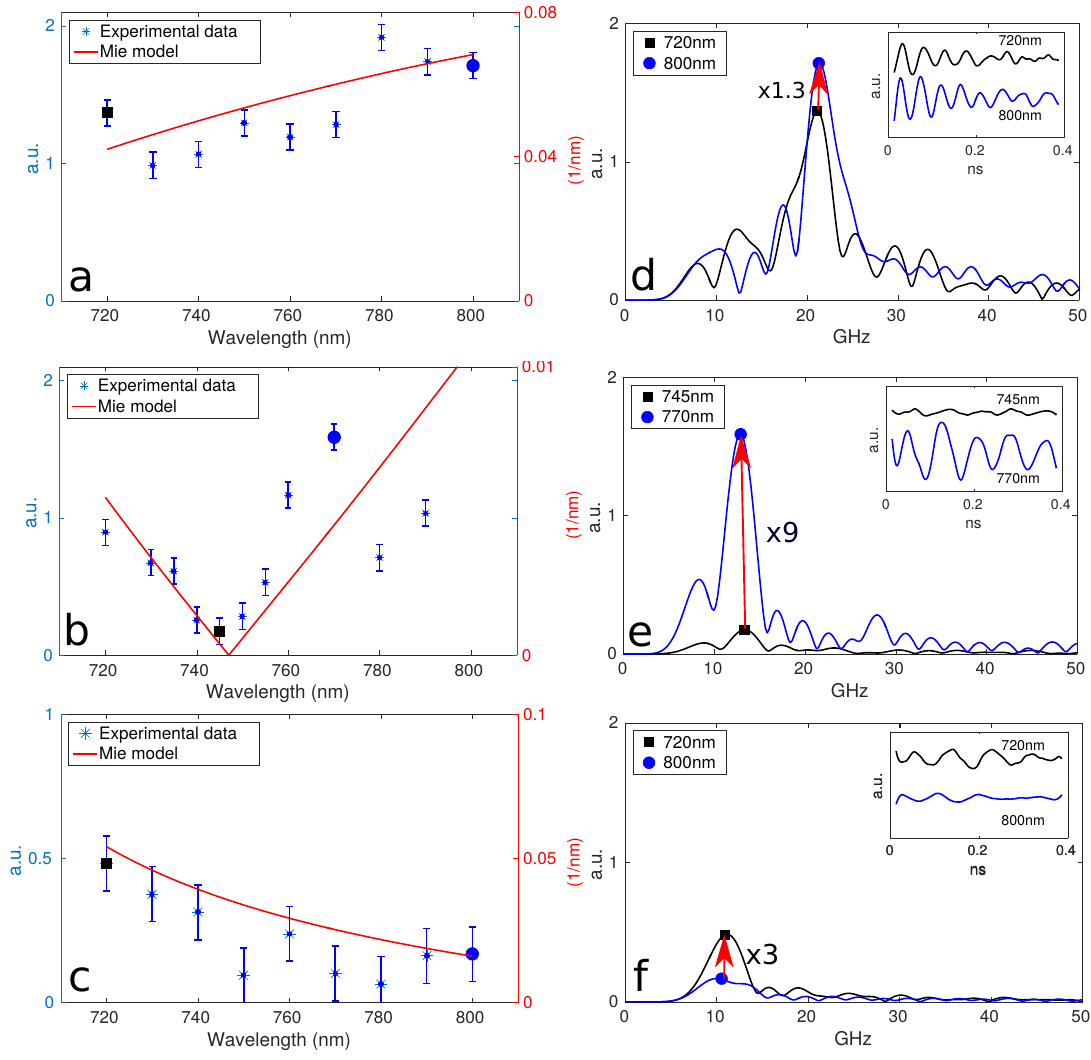
Figure 3. Measured amplitude (blue) and theoretical modulation depth (red) for: ( a ) 150 nm; ( b ) 200 nm and ( c ) 250 nm gold nanoparticle in water tuning the probe laser wavelength from 720 to 800 nm measuring the reflected light; ( d – f ) show the oscillation amplitudes (small box figure), their frequency spectra and the degree of enhancement for the circle and squares from